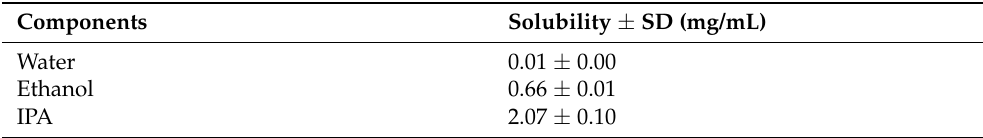
Table 1. Equilibrium solubility values of apremilast (APR) in different oils, surfactants, cosurfactants, and water at 25 ◦ C (mean ± SD, n =